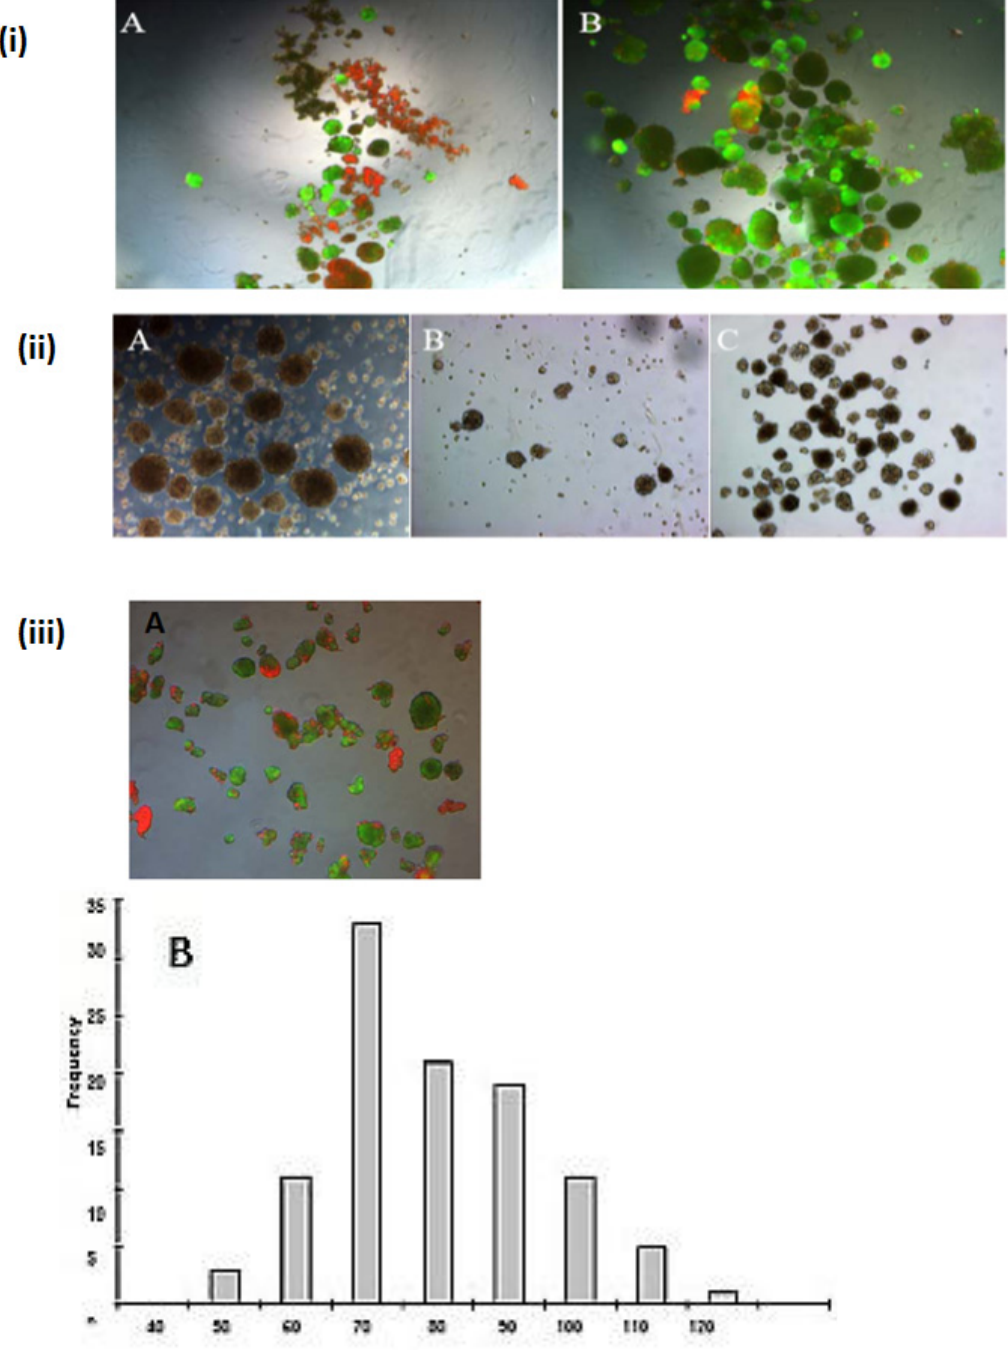
Figure 6. Speriod formation before the Percoll purification and after the